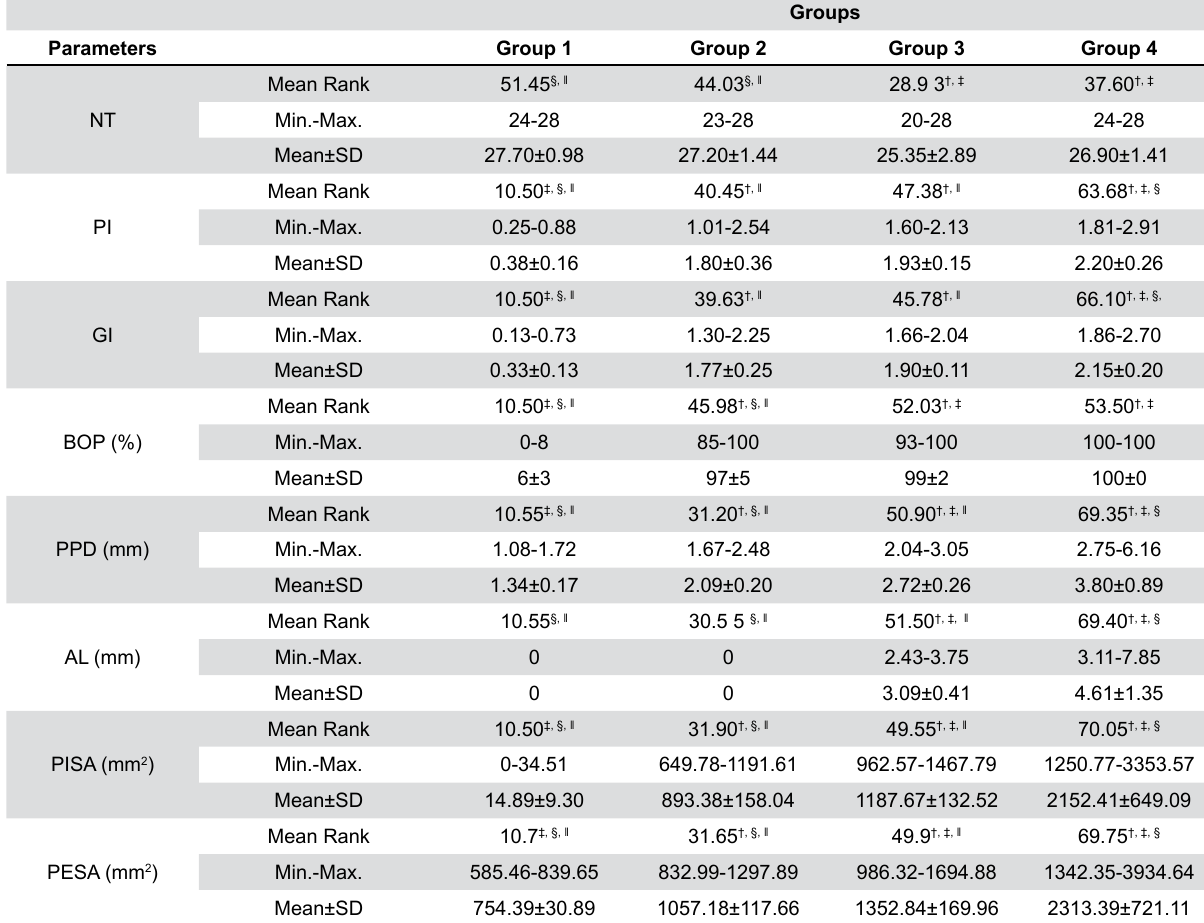
Table 2- Dental and periodontal characteristics and periodontal epithelial and periodontal inflamed surface area (PISA and PESA) values of the study